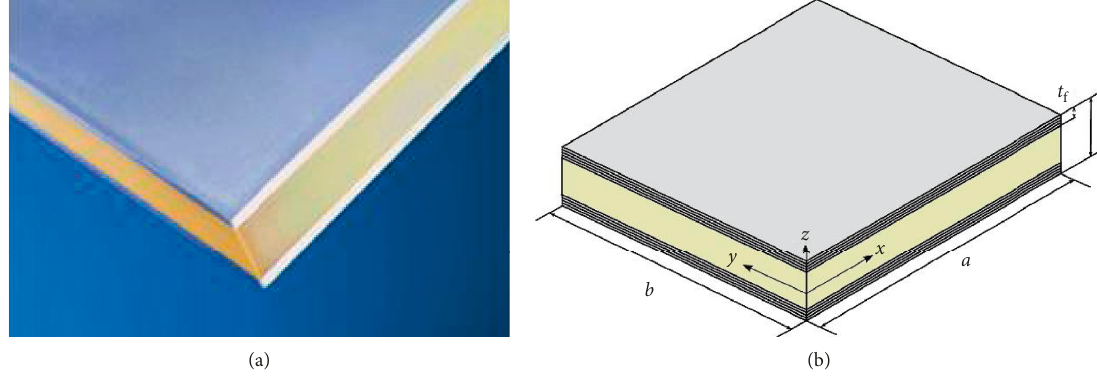
Figure 2: SPS structure: (a) system sandwich plate system; (b) schematic view of SPS